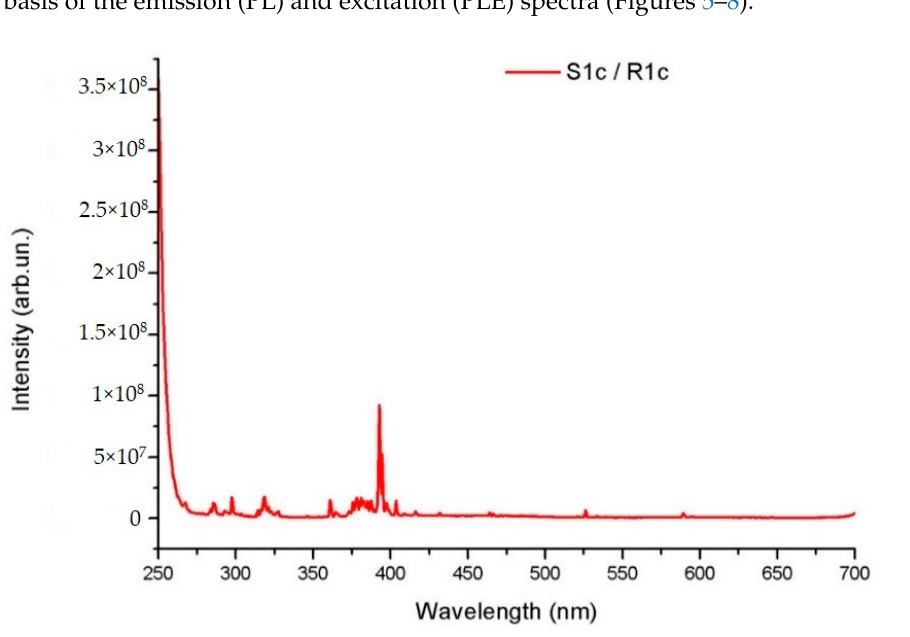
Figure 5. The PLE spectra of YAG:Eu (2%).